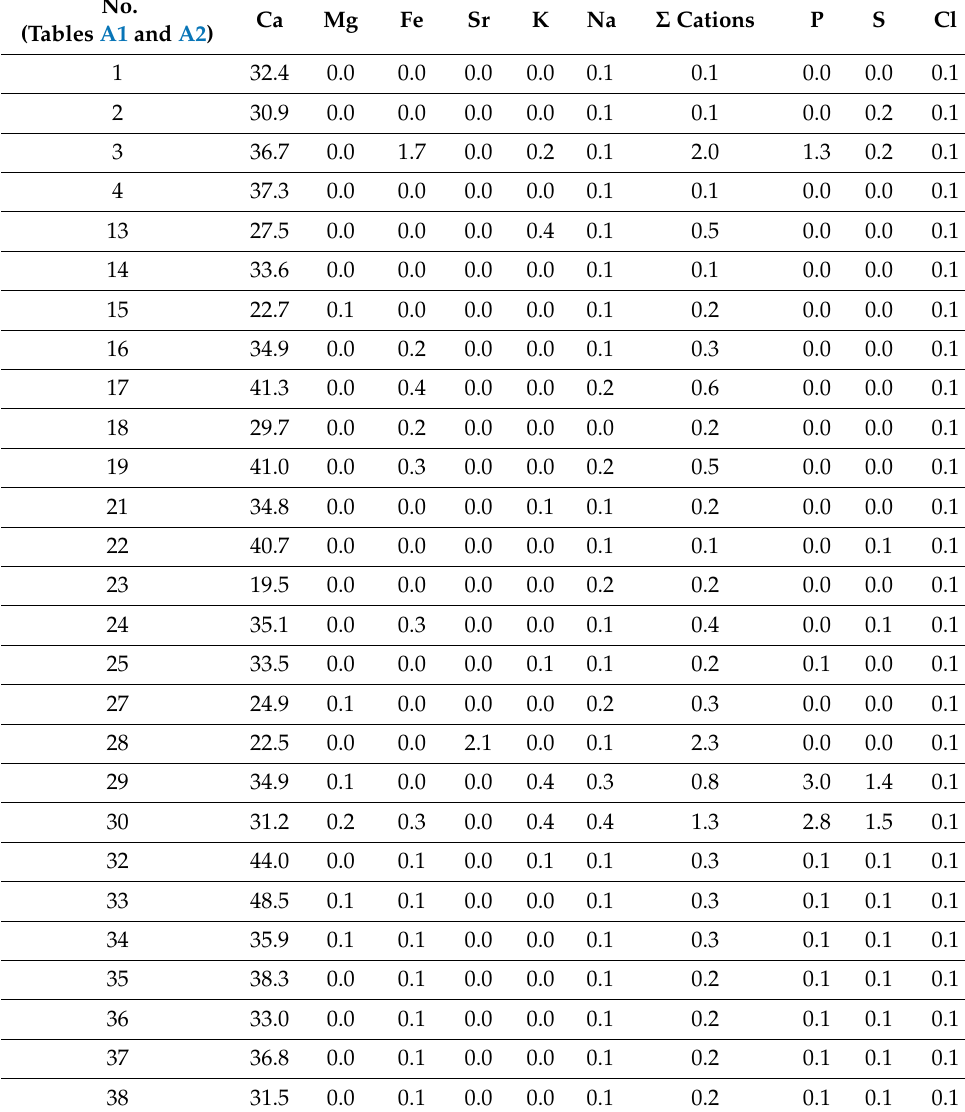
Table A3. Elemental composition of precipitates, wt% (EDXS data)